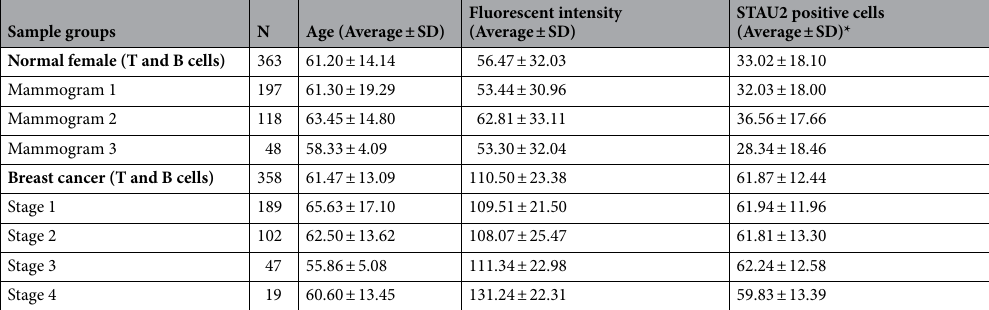
Table 1. The following 3 fluorescent signals were observed: (1) Hoechst (blue) is a nuclear stain used to identify the WBC position; (2) anti-CD45 + (red) binds to a CD45 + molecule, which is a general protein expressed in WBCs; and (3) anti-STAU2 (green) is an antibody that binds to a candidate protein marker for breast cancer screening. Anti-CD45 + (red) was observed in WBCs from both breast cancer patients and healthy females (Fig. 1A). The fluorescent signals from anti-STAU2 were indicated in WBCs from breast cancer patients. (Fig. 1B). Secretory effect in coculture model.